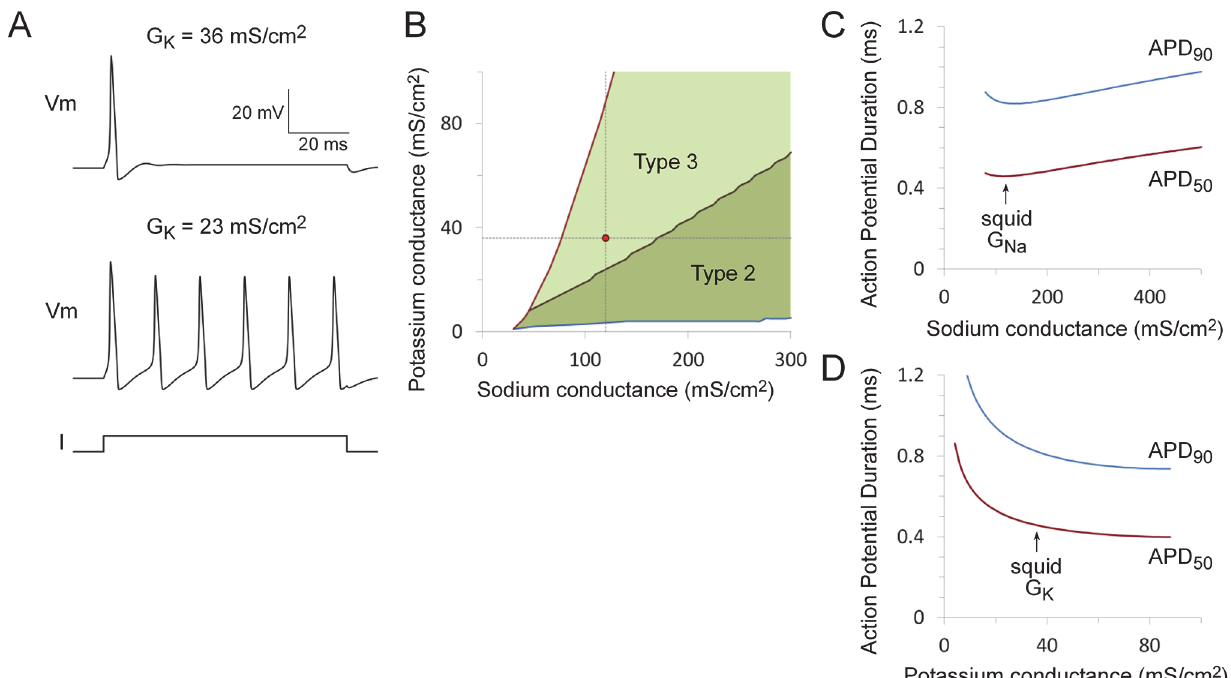
Fig 3. Effect of variations in sodium and potassium channel expression on firing patterns and action potential duration. A. Effect of reducing potassium conductance on excitability. At the normal potassium conductance of 36 mS/cm 2 , the axon model displays Type 3 excitability properties and is refractive after firing a single action potential in response to a sustained depolarizing current step. The axon is converted to Type 2 excitability and begins to fire repetitively following a reduction in potassium conductance (23 mS/cm 2 ). The stimulus current was twice the size of the just-threshold current required to trigger an action potential and the sodium conductance was held constant at 120 mS/cm 2 . B. Region of sodium and potassium conductance parameter space that has Type 3 (light green area) or Type 2 (dark green area) firing properties. C. Dependence of action potential duration on peak sodium conductance. Action potential duration at 50% (red) and 90% (blue) of peak height are shown (APD50 and APD90, respectively). D. Dependence of action potential duration on peak potassium conductance. For the simulations shown in panels C and D, one voltage-gated conductance was kept constant (either potassium conductance = 36 mS/cm 2 or sodium conductance = 120 mS/cm 2 ), while the other conductance was swept over the range of conductance values for which action potential conduction did not fail at 26°C (Fig 2A). The leak conductance was kept constant (0.3 mS/cm 2 ) for all simulations. The simulation temperature was 18.5°C for panels C and D and 6.3°C for panel A (see Methods).